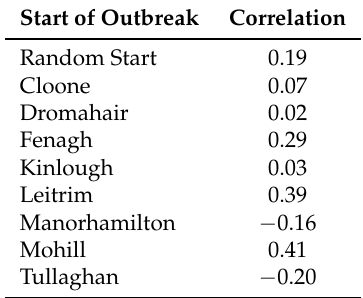
Table 12. Correlations between the percent of runs that lead to an outbreak and the out-degree centrality of the town by starting location of the